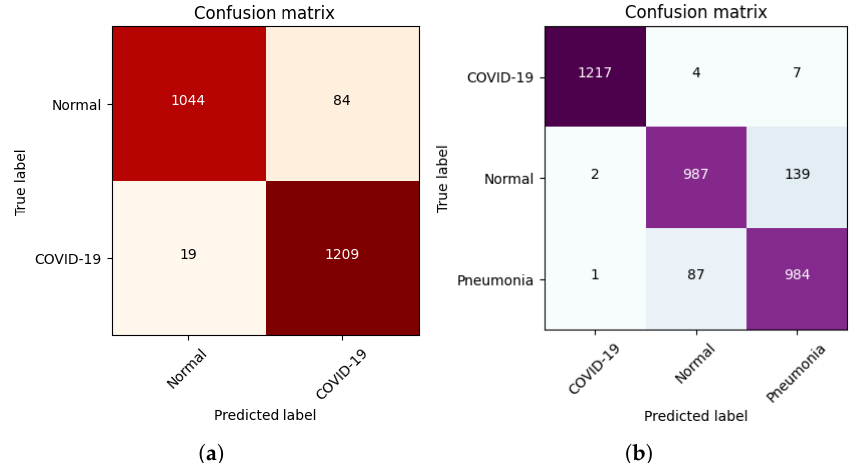
Figure 19. Confusion matrix of both models: ( a ) DeepCCXR-Bin (COVID-19 vs. normal); ( b ) DeepCCXR-Bin (COVID-19 vs. other pneumonia vs.